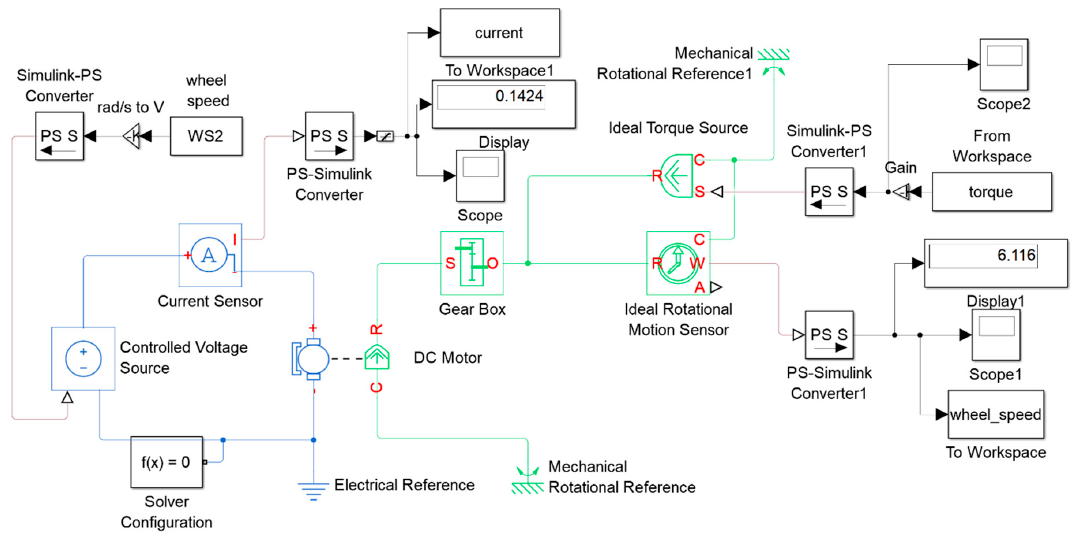
Figure 30. Block diagram of the actuation system.